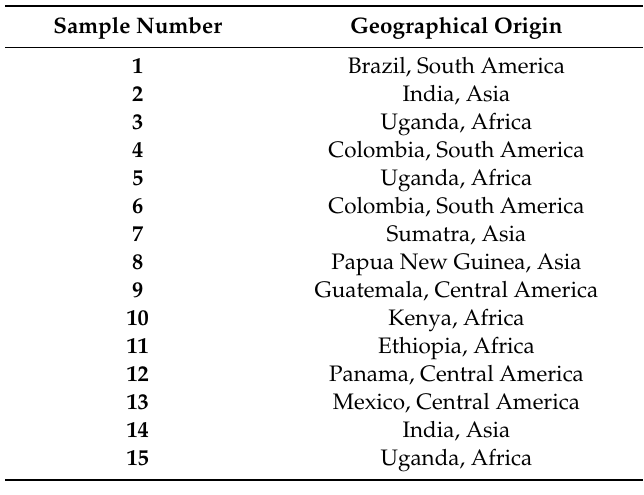
Table 1. Description of co ff ee